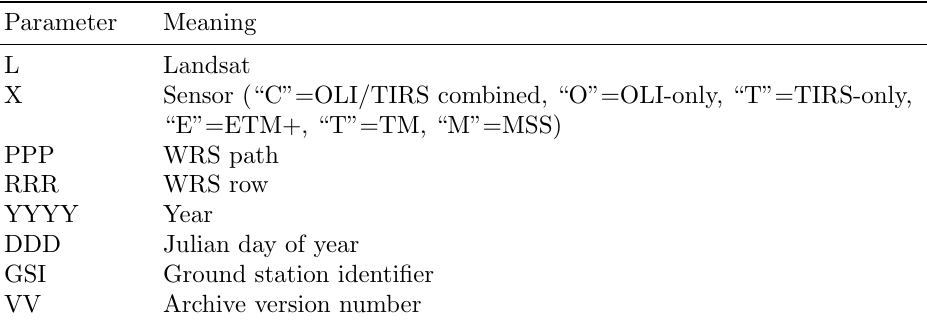
Table 3: Overview of folder naming convention for Landsat images Parameter